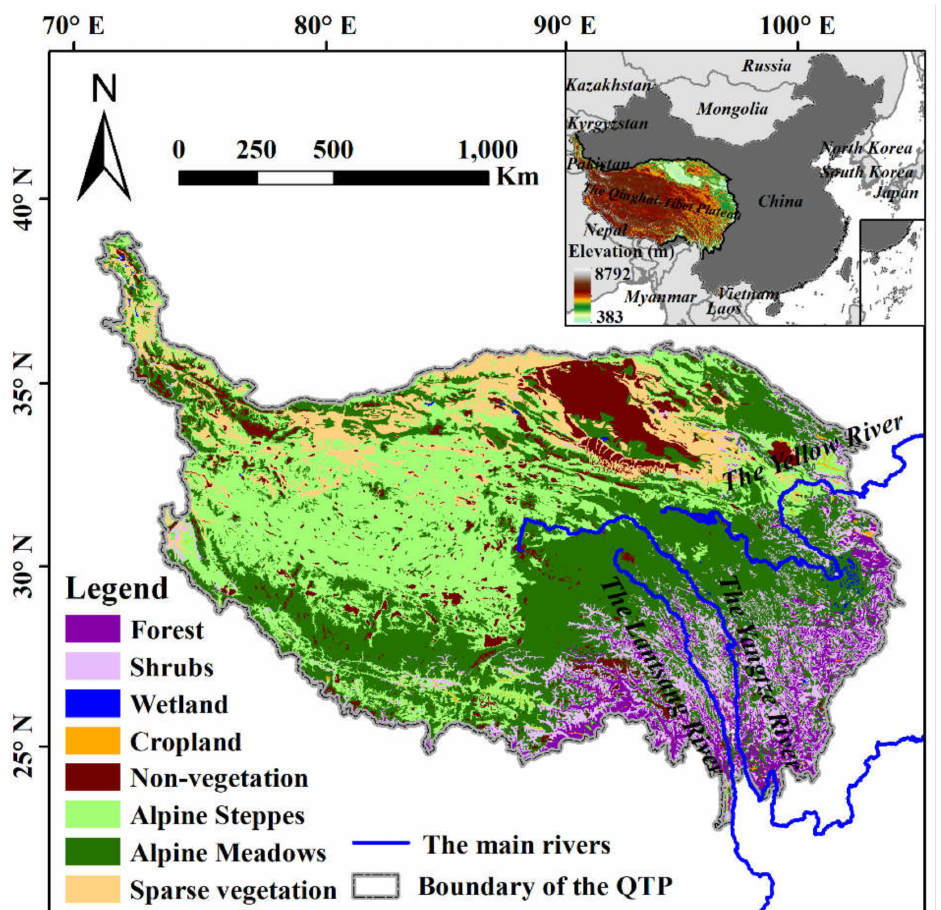
Figure 1. Location of the QTP in China. The color map of the upper-right inset shows the elevation of the QTP. The main map presents the vegetation types of the QTP.